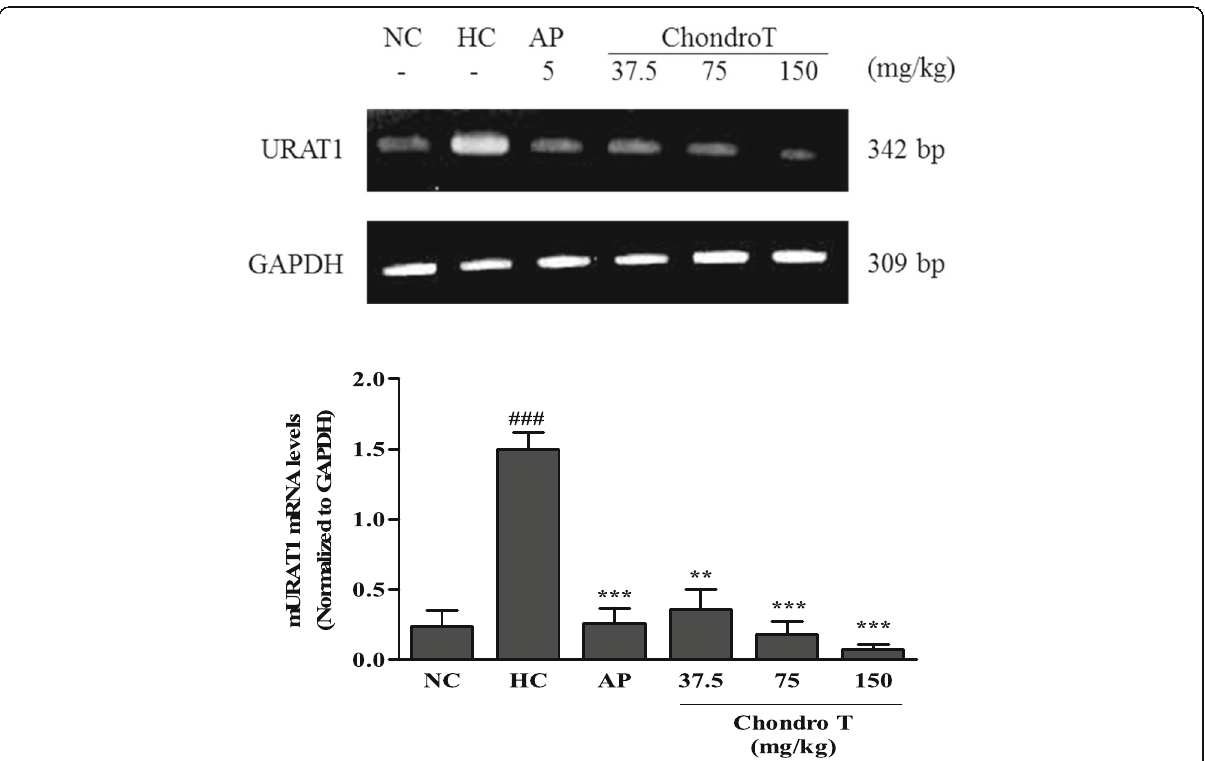
Fig. 3 Effects of ChondroT on mRNA levels of mouse urate transporter 1 (mURAT1) in kidney tissues of potassium oxonate (PO)-induced hyperuricemic mice using reverse transcription-polymerase chain reaction (RT-PCR). The relative mRNA expression levels of the mURAT1 gene were normalized against GAPDH NC, normal control; HC, hyperuricemic control with potassium oxonate (300 mg/kg); AP, allopurinol (5 mg/kg). Values are expressed as the mean ± standard error (S.E., n = 5). ### P < 0.001 compared with NC group; ** P < 0.01 and *** P < 0.001 compared with HC group